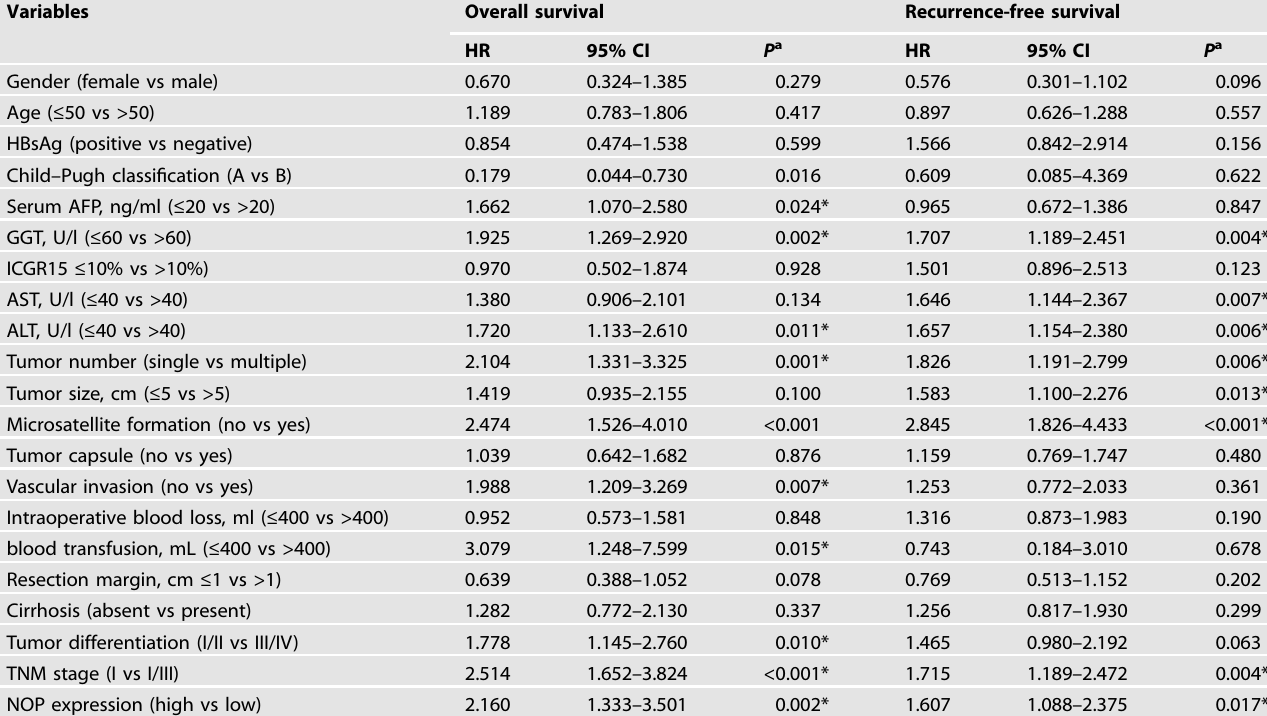
Table 2. Univariate analysis of factors associated with OS and RFS in HCC patients ( n = 288). Variables Overall